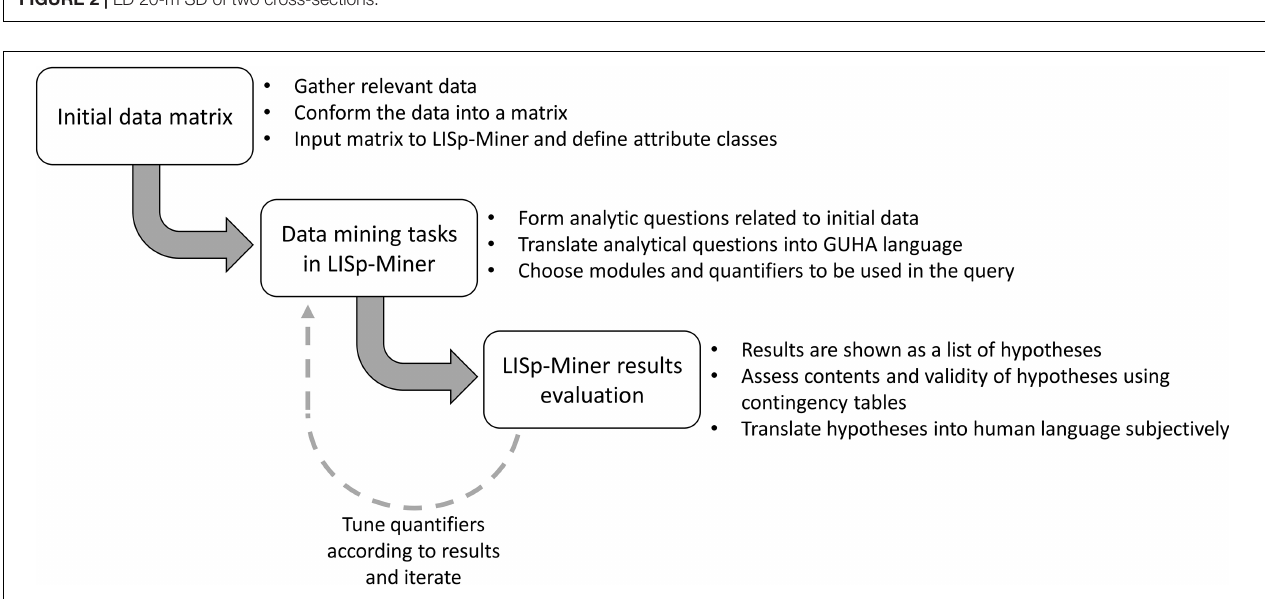
FIGURE 2 | LD 20-m SD of two cross-sections.